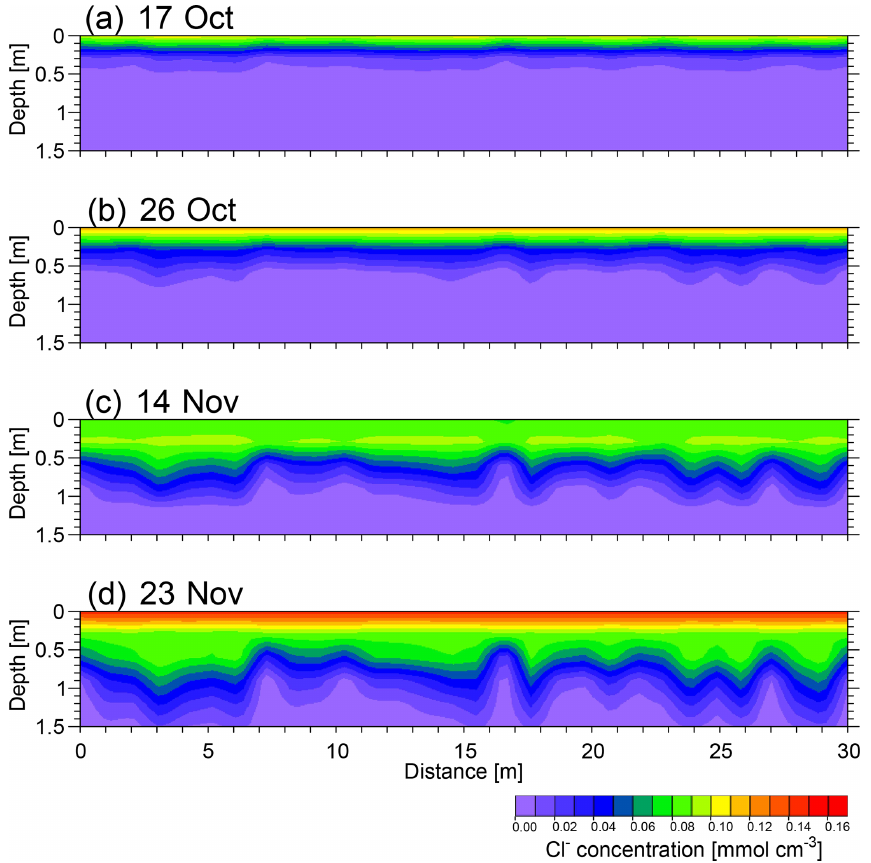
Figure 7. Soil Cl − concentration distribution simulations for the selected scenario: (a) 17 October, (b) 26 October, (c) 14 November and (d) 23 November